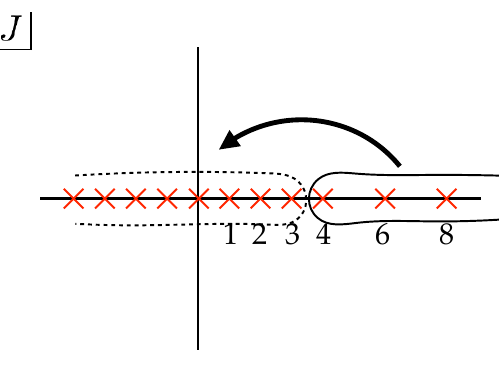
Figure 3 . Deforming the contour in the complex J